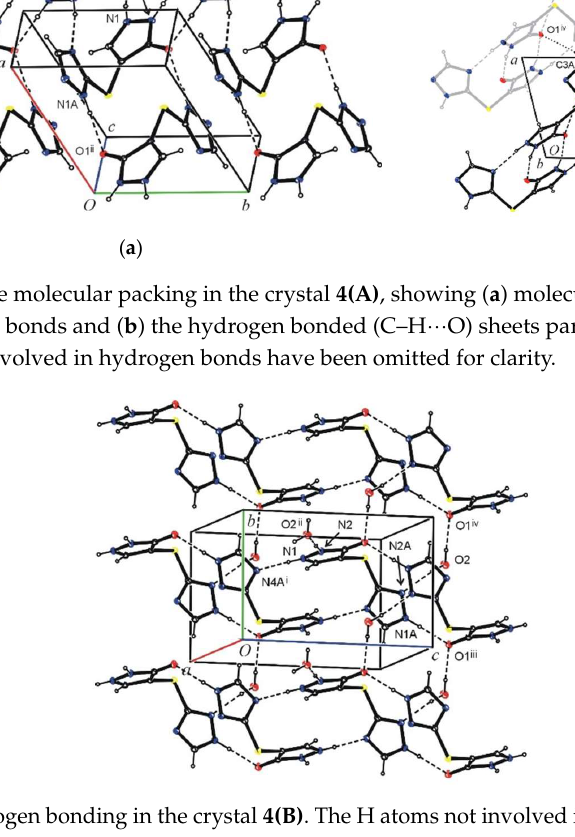
Figure 3. The hydrogen bonding in the crystal 4(B) . The H atoms not involved in hydrogen bonds have been omitted for